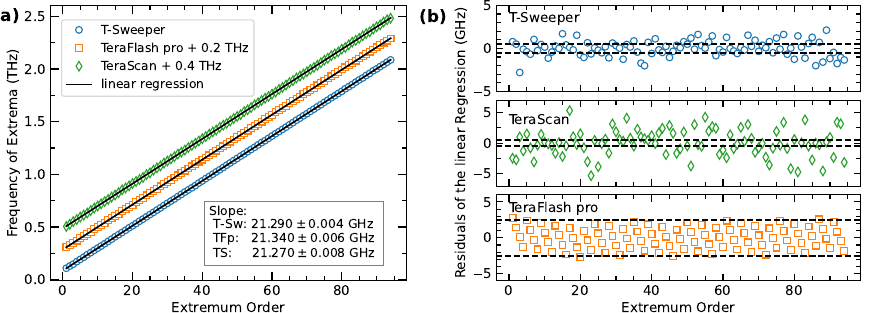
Figure 4. ( a ) Frequency of the peak maxima plotted versus peak order, with the linear fit for all three devices. For clarity, values of the TeraScan and TeraFlash pro have been offset. The slopes of linear regression are shown in the bottom right inset. Since this is the distance between the successive minima and maxima, this must be doubled for the calculation of FSR (cf. above). ( b ) Frequency residuals of extreme values, measured with T-Sweeper, TeraFlash and TeraScan. The dashed lines represent half the frequency resolution.